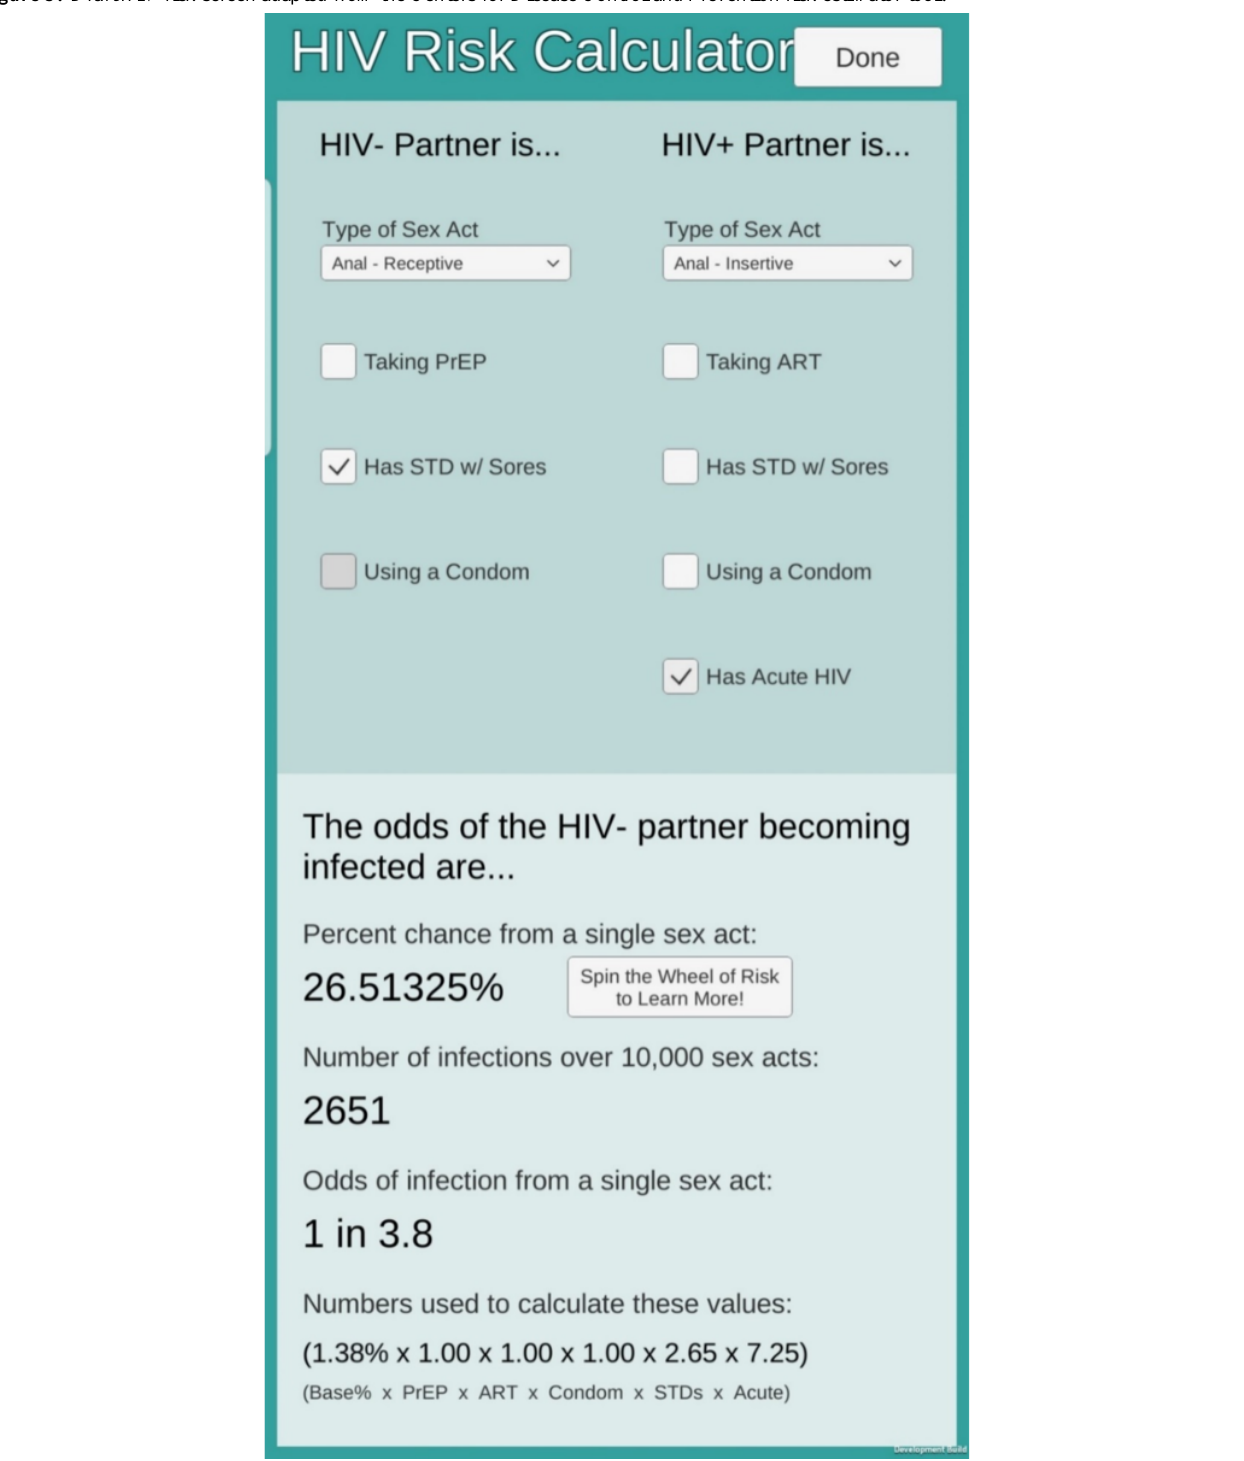
Figure 3. Draft HIV risk screen adapted from the Centers for Disease Control and Prevention risk estimator